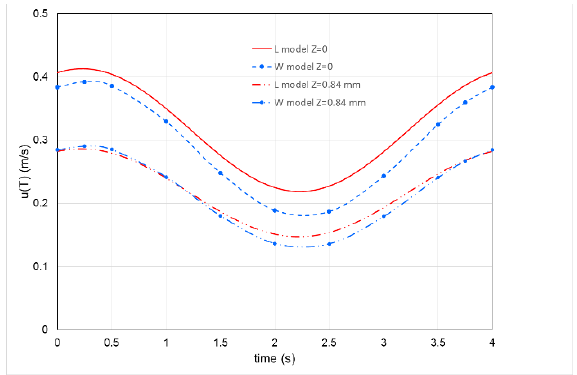
Figure 7. 𝑢 0 + 𝜀𝑢 1 + 𝜀 2 𝑢 20 at layer axis and at Z = 0.6  as function of time (frequency of disturbance Figure 7. u 0 + ε u 1 + ε 2 u 20 at layer axis and at Z = 0.6 δ as function of time (frequency of disturbance